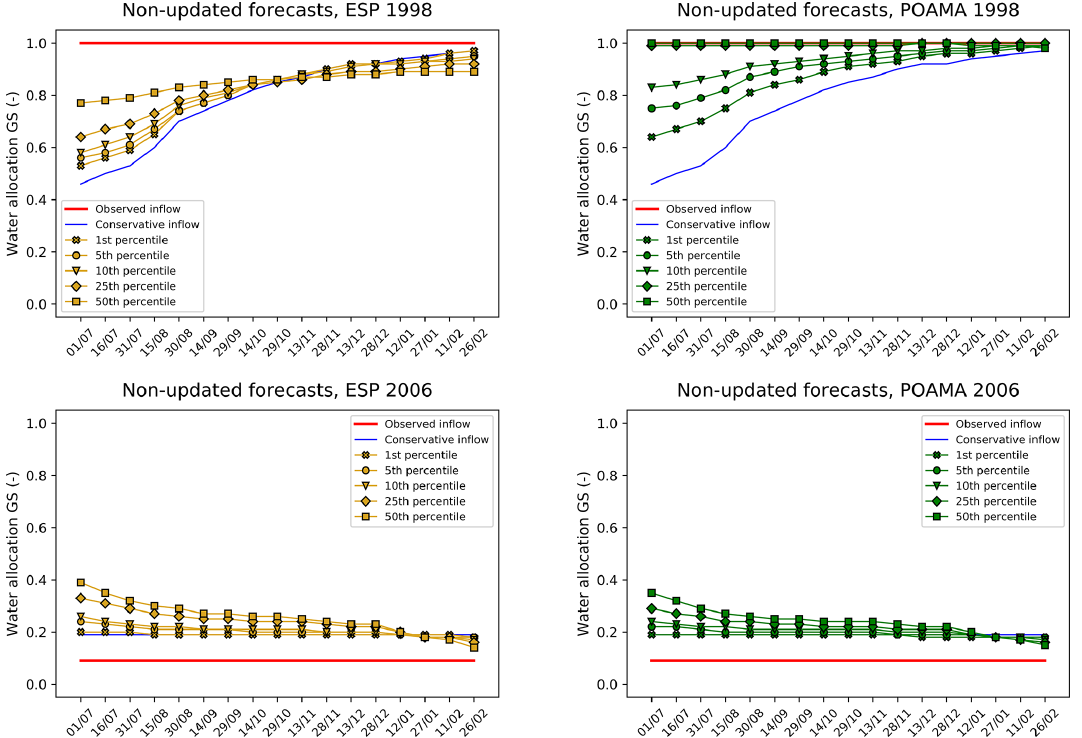
Figure 8. Water allocation GS for one wet year (1998) and one dry year (2006) using one inflow prediction at the beginning of the water year for the next 12 months (non-updated